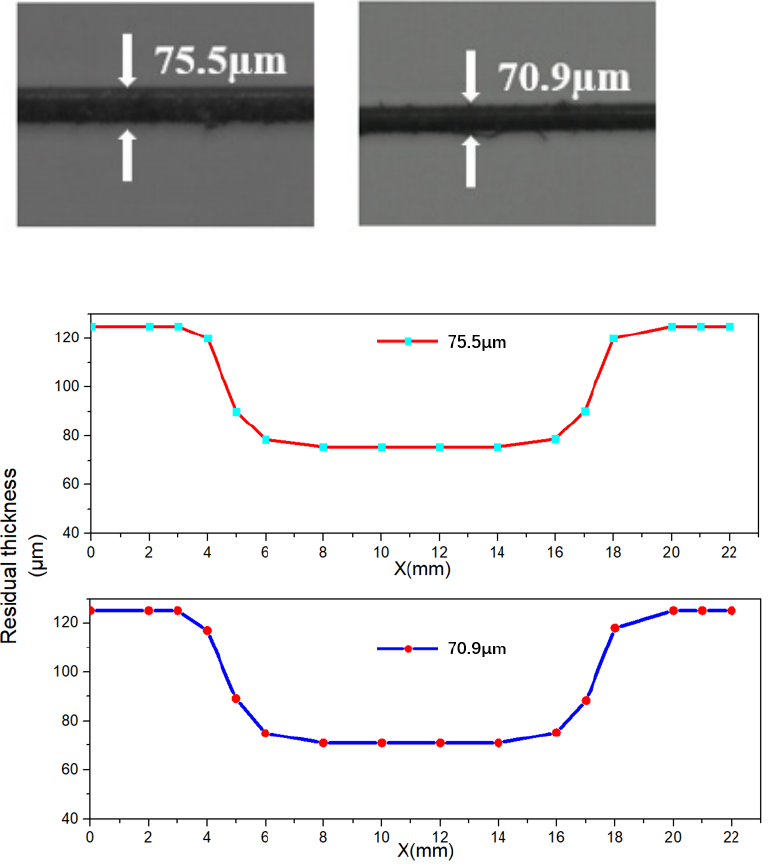
Figure 5. Side view microscopic images of the RT of Side-polished fibers. The RTs were measured as 75.5 μ m and 70.9 μ m, respectively and Variations of residual thicknesses for the two fabricated side-polished fibers.